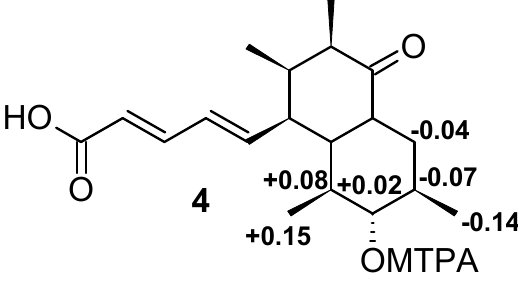
Figure 4. Δδ SR chemical shifts of MTPA ( α‐ methoxy ‐α‐ trifluoromethylphenylacetic acid) (Mosher) Figure 4. ∆ δ SR chemical shifts of MTPA ( α -methoxy- α -trifluoromethylphenylacetic acid) (Mosher) derivatives of elsinopirin B ( 2 ). derivatives of elsinopirin B ( 2